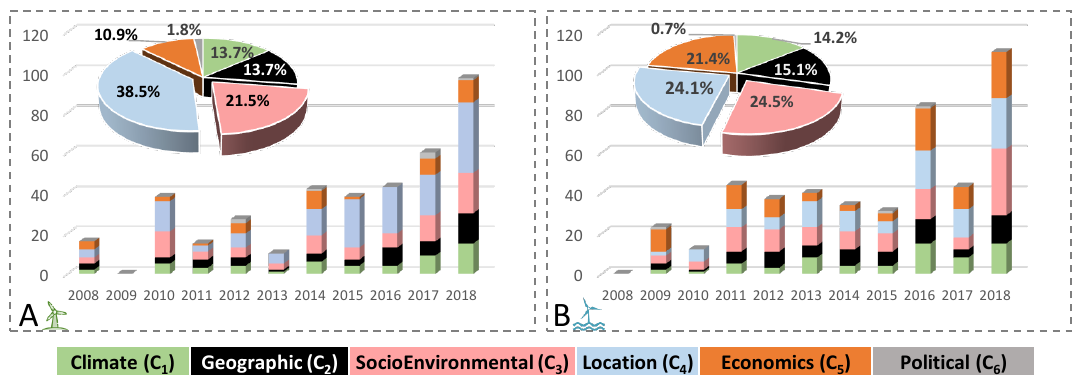
Figure 7. Categories: relevance and comparison (2008–2018). ( A ) Onshore wind power plant. ( B ) Offshore wind power plant.